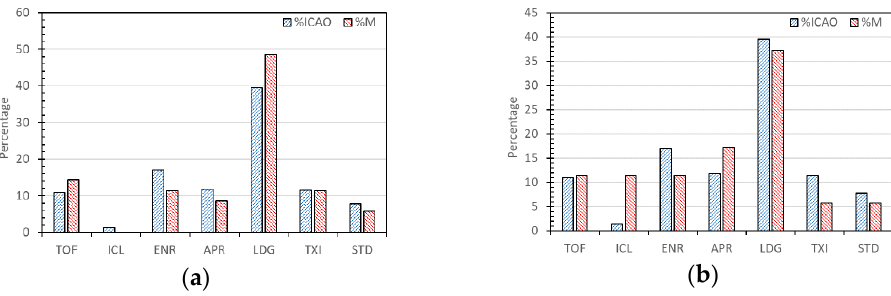
Figure 3. Distribution of phase of flight for accidents with maintenance contributions: ( a ) the phase in which the accident occurred (end result); ( b ) the phase in which the maintenance issue manifested.